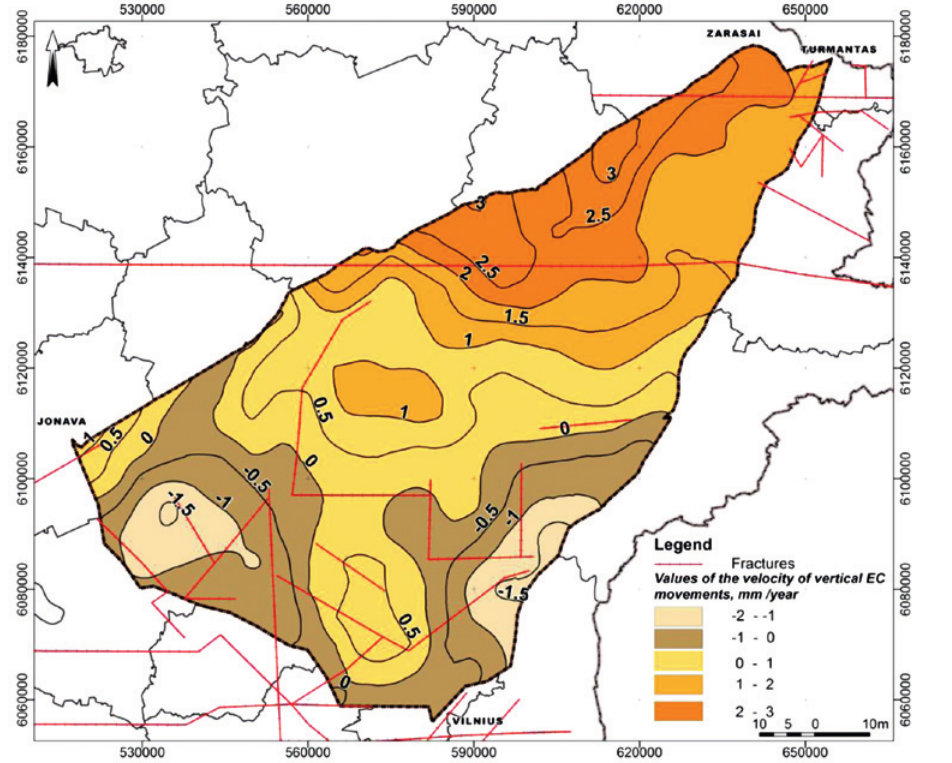
Fig. 4. Velocities (mm/year) of recent vertical movements of the earth’s crust in the territory enclosed